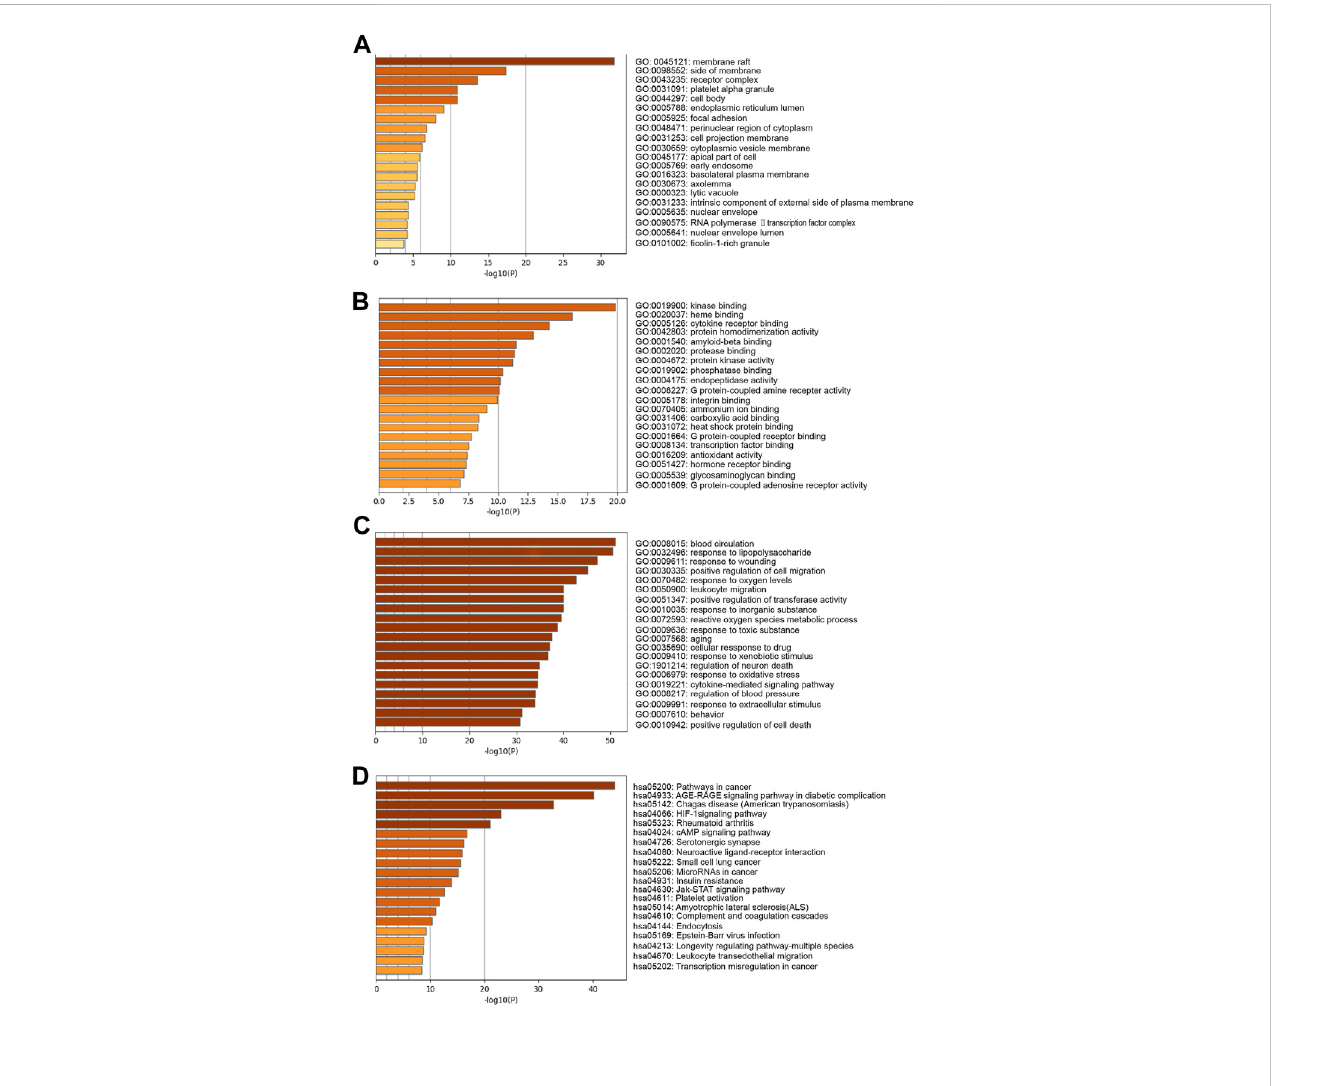
FIGURE 3 KEGG and GO enrichment analysis. GO enrichment diagram of phenolic acids and cerebral ischemia hub target. (A) “ cellular components ” ; (B) “ molecular function ” ; (C) “ biological process ” . Sort by − Log10 ( p -value) importance of each pathway. (D) KEGG pathway analysis of phenolic acids and ischemic stroke core target. Sort by − Log10 ( p -value) importance of each